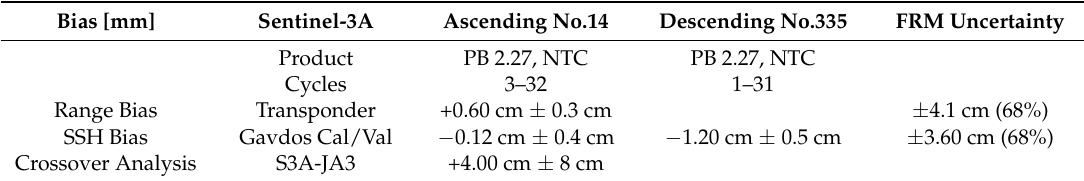
Table 3. Latest results of the Sentinel-3A Pass No.14 and Sentinel-3A Pass No.335 range and sea-surface bias at the Permanent Facility for Altimetry Calibration in west Crete,